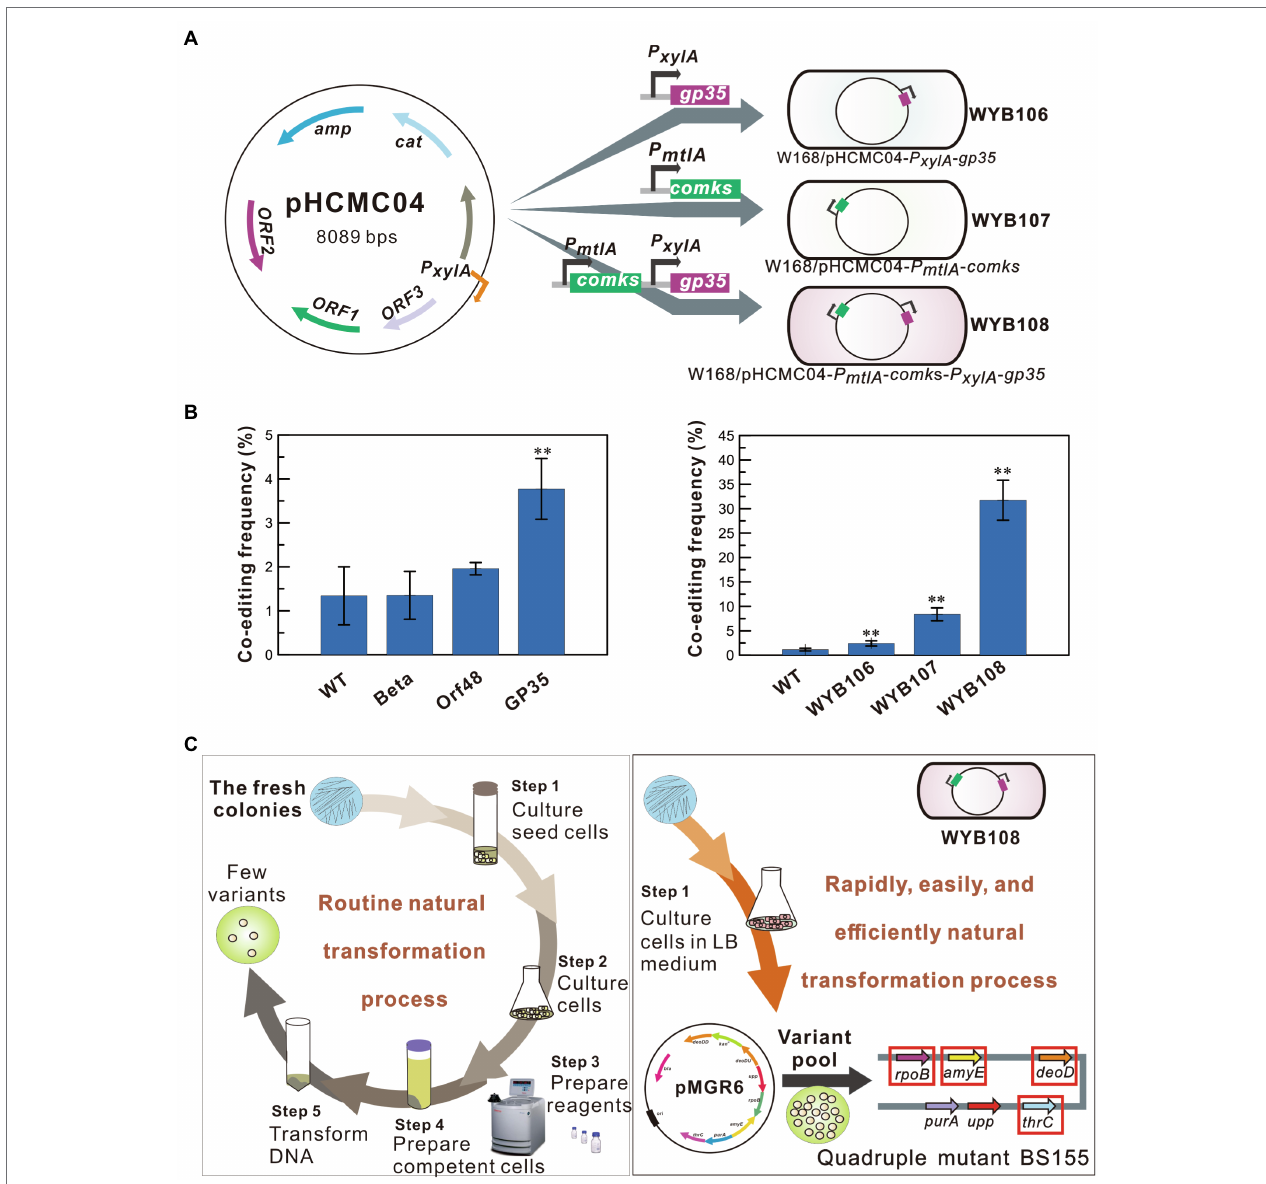
FIGURE 4 | Enhancement of the co-editing frequency by recombinase and competency factor. (A) A schematic illustration of the high-recombinant strains generated by expressing the recombinase or/and the competency factor. (B) The co-editing frequencies of the high-recombinant strains expressing the recombinase or/and competency factor. All error bars indicate ± SD, n = 3. A value of P less than 0.05 was regarded to be a significant difference using the T -test (** p < 0.01). (C) Rapid and efficient simultaneous modification of four genetic loci in the high-recombinant strain WYB108 via simple natural